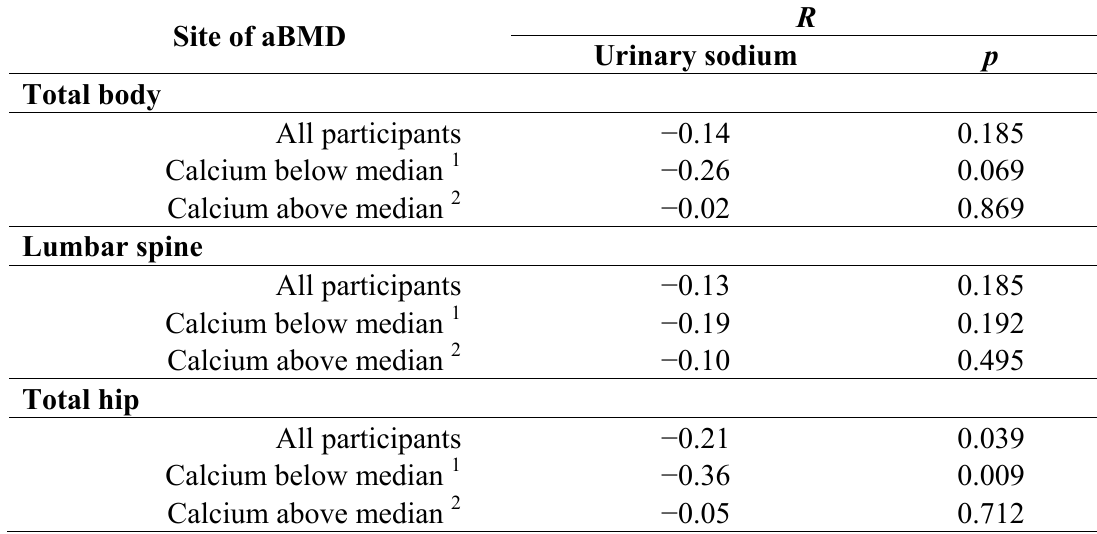
Table 2. Correlations among urinary sodium and areal bone mineral density in all participants and women with calcium intakes below and above the